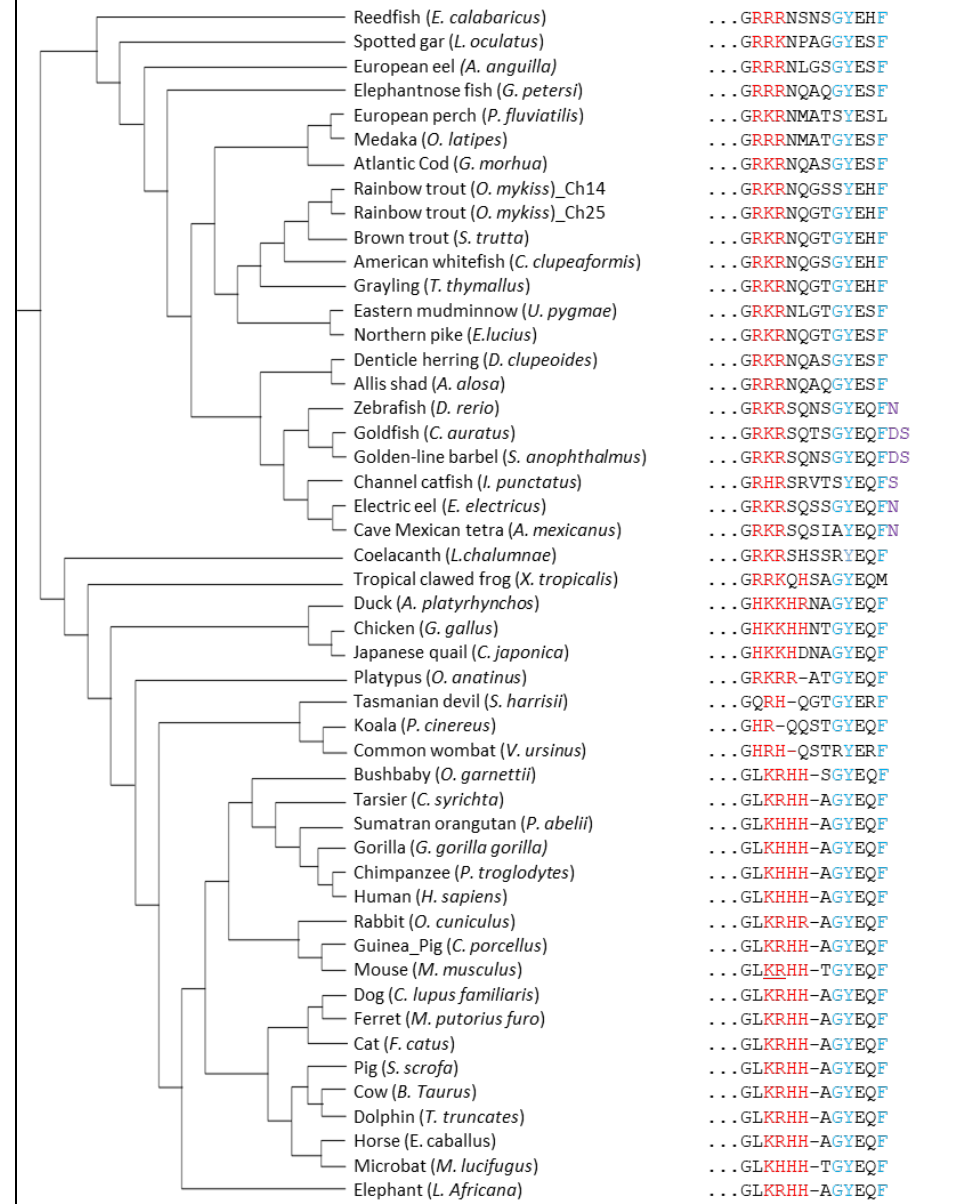
Figure 6. Protein sequence alignment of the short CT tail of LAMP2A from different vertebrates. Positively-charged amino acids required for the binding of substrate proteins are colored in red. The GY dipeptide as well as the hydrophobic F required for the targeting of LAMP2A to lysosomes are in blue. The additional residues at the C-terminus of LAMP2A from fish belonging to ostariophysans are in purple. The K406 and R407 of mouse LAMP2A are underlined.